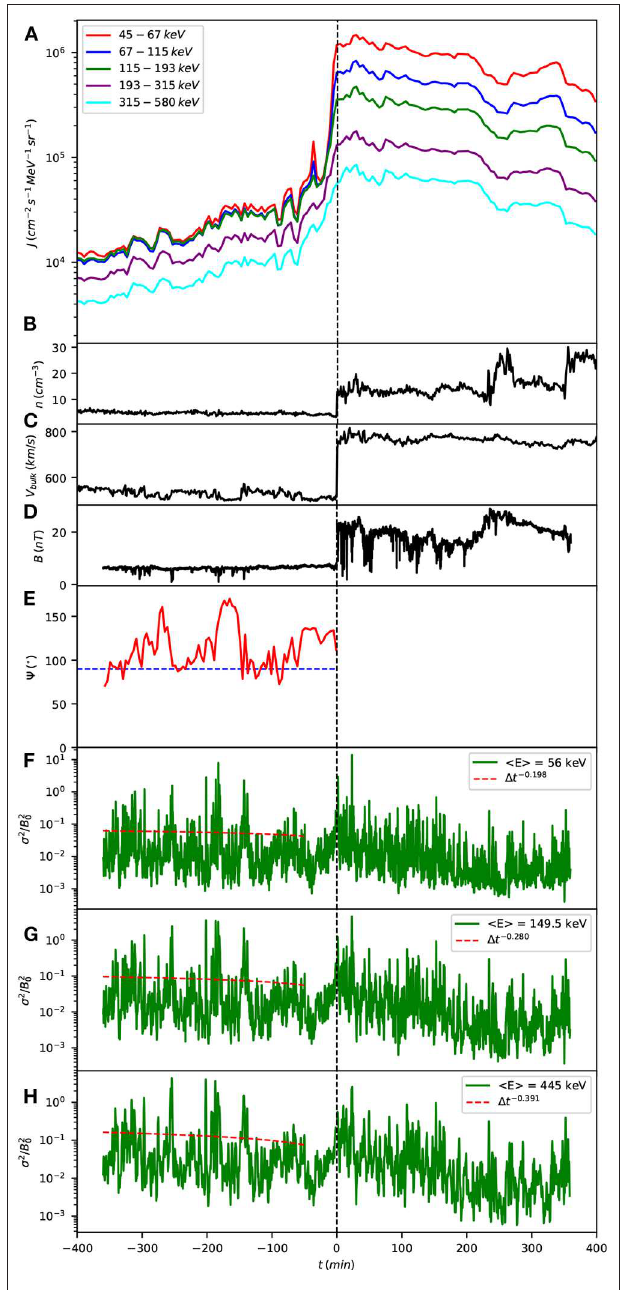
FIGURE 3 | Same as Figure 1 but for the ACE shock crossing of 8 June 2000. The shock normal angle was θ Bn = 50 ◦